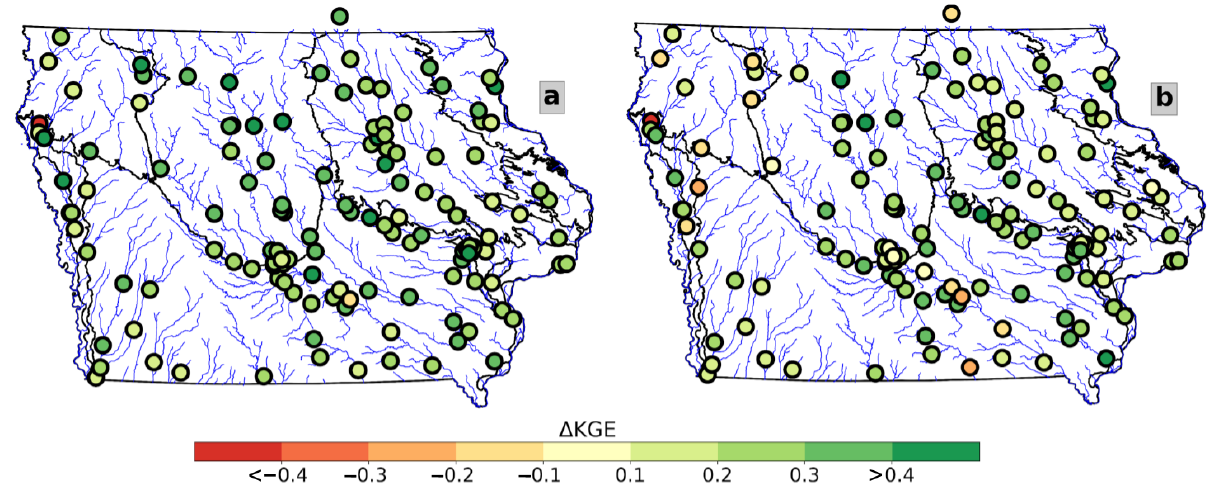
Figure 9. Mean KGE spatial difference of the diagnostic and prognostic scenarios with respect to the linear model: ( a ) diagnostic KGE minus linear model KGE; and ( b ) prognostic KGE minus linear model KGE.